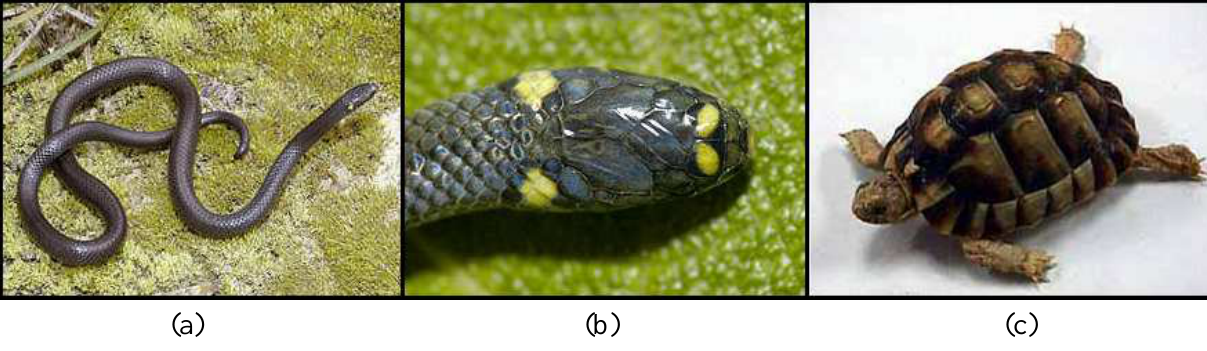
Figure 6. Suitable animals for TD method [29,30].